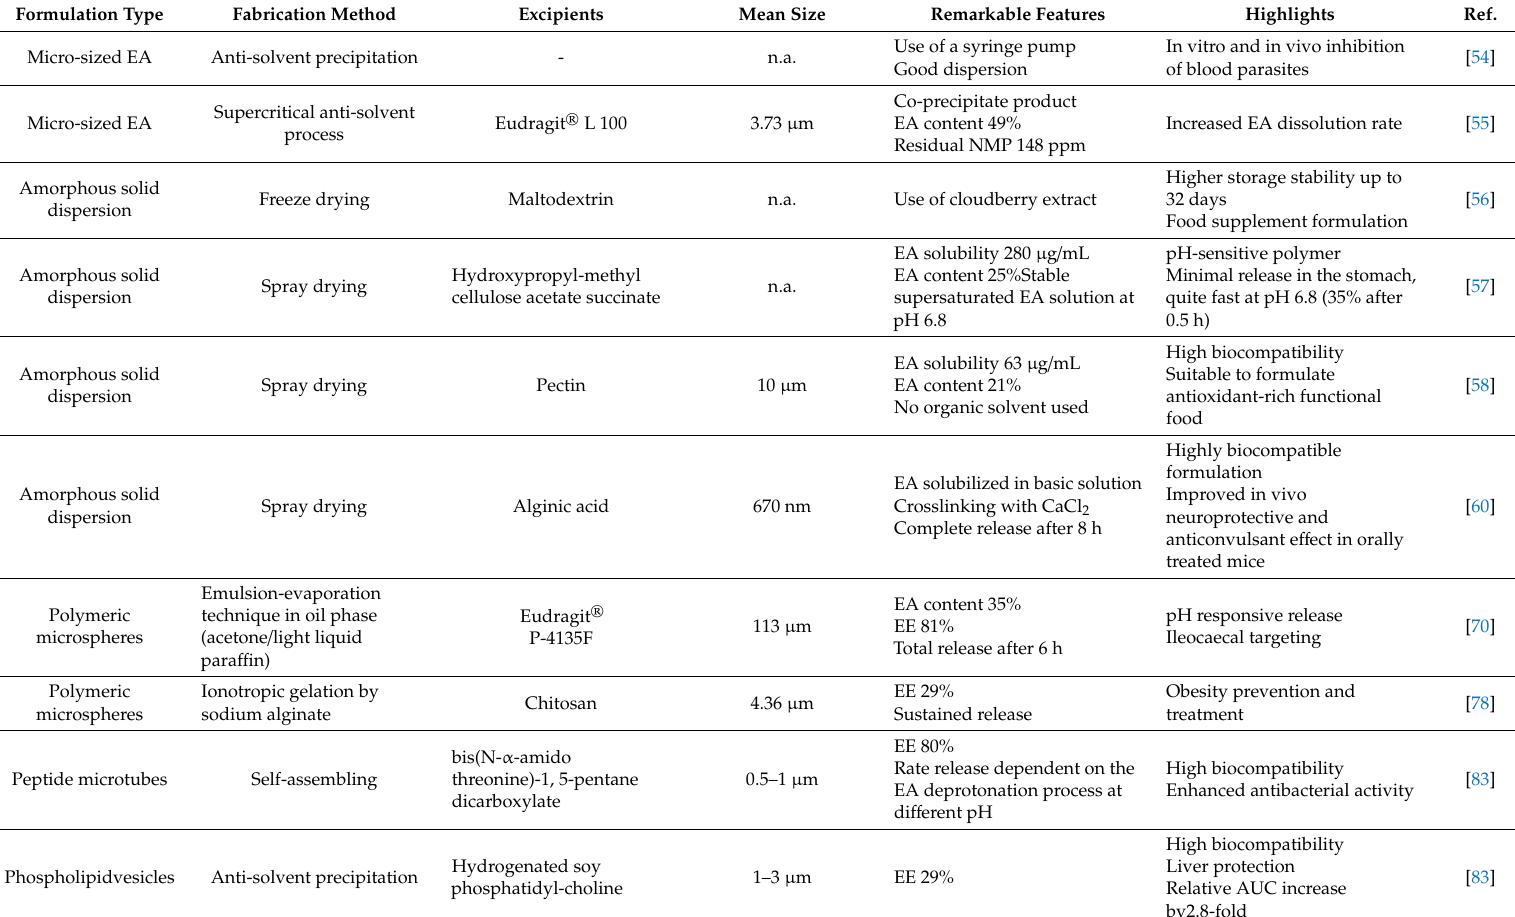
Table 2. EA micro-sized formulations and their distinctive